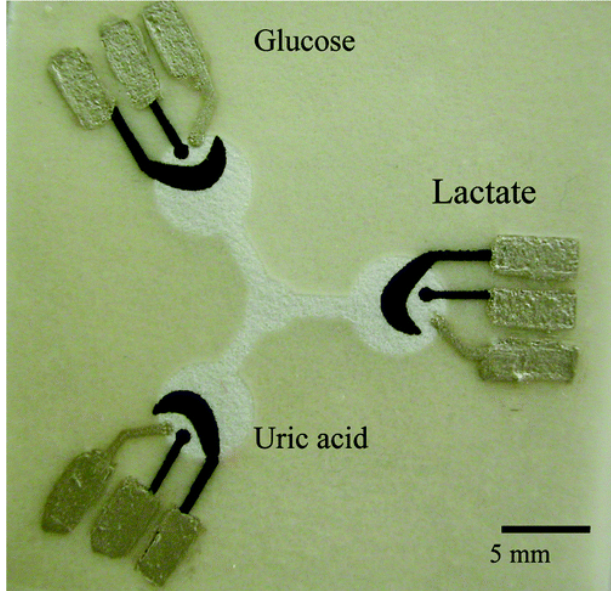
Figure 6. Paper-based microfluidic devices with three electrode system (counter and working electrodes consisting of carbon, and reference electrode consisting of silver/silver chloride) for the electrochemical analysis of glucose, lactate and uric acid. Each of the working electrodes were individually spotted with glucose oxidase, lactate oxidase and uric acid. (Reprinted with permission from Dungchai et al. Anal. Chem. 2009 , 81 , 5821–5826. Copyright © 2009 American Chemical Society